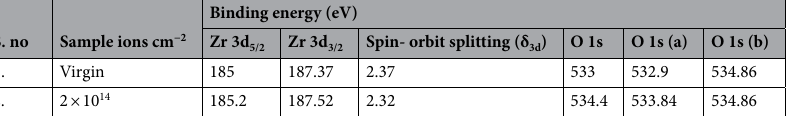
Table 3. Summary of the chemical properties of the films determining the binding energy of Zr 3d 5/2, Zr 3d 3/2 and δ 3d (energy separation between the Zr 3d 5/2 and Zr 3d 3/2 levels) and O 1s using XPS.